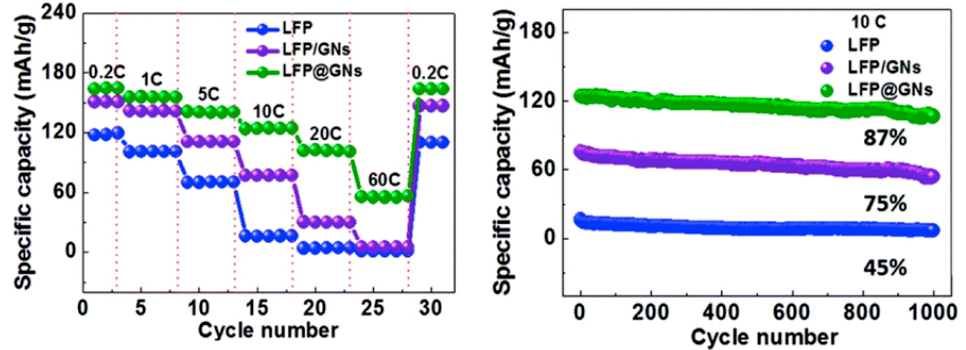
Figure 3. ( Left ) Rate capabilities from 0.2 C to 60 C. ( Right ) Long-term cycling stabilities at a 10 C rate of LiFePO 4 (LFP), LiFePO 4 ex situ modified with graphene LFP/GNs, and LiFePO 4 nanoplatelets grown in situ on graphene sheets with highly oriented (010) facets of LiFePO 4 (LFP@GNs). Reproduced from [65].